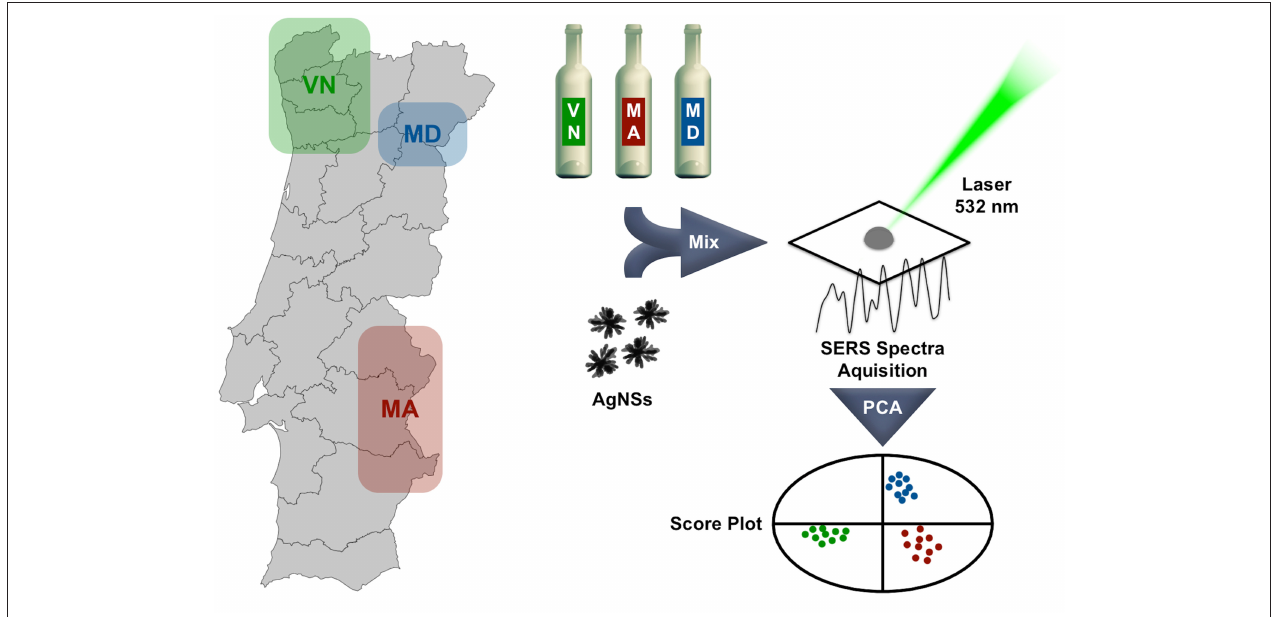
FIGURE 1 | White wine samples from three different wine regions in Portugal are simply mixed with a silver nanostars colloid and incubated. A 532nm laser is used to obtain the respective SERS spectra, that after principal component analysis (PCA) produces a score plot allowing sample discrimination. The duration of the incubation period is determinant for the obtained